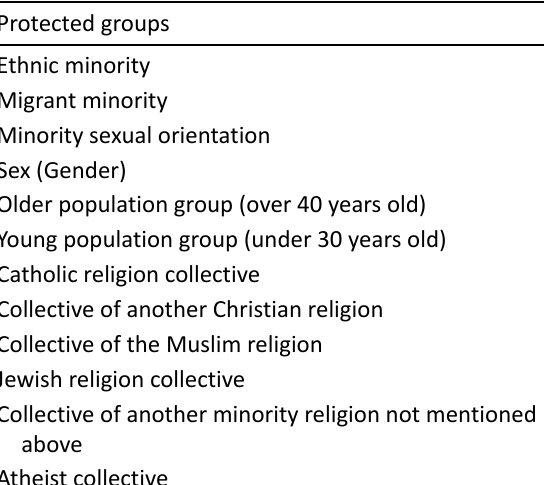
Table 1. Diversity of identification groups. Protected